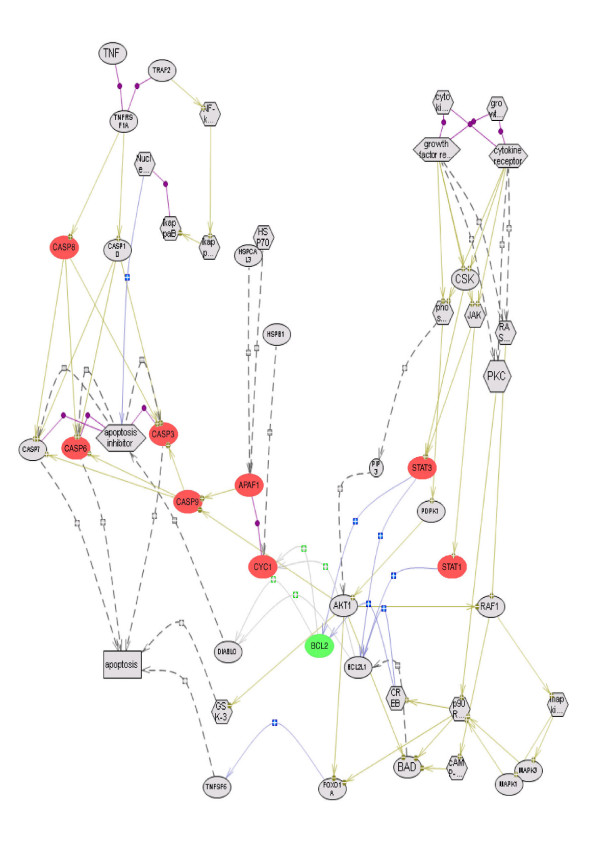
Pathway-analyses based on decreased (green) and increased (red) genes detected in fibrosarcoma cells after 24 h treatment with doxorubicin. Results shown for apoptosis. Signaling pathway maps were identified using the software package Pathway Assist. A minimum of 3 interacting genes is the required criteria for creation of a map (Software: Pathway Assist™ Stratagene).